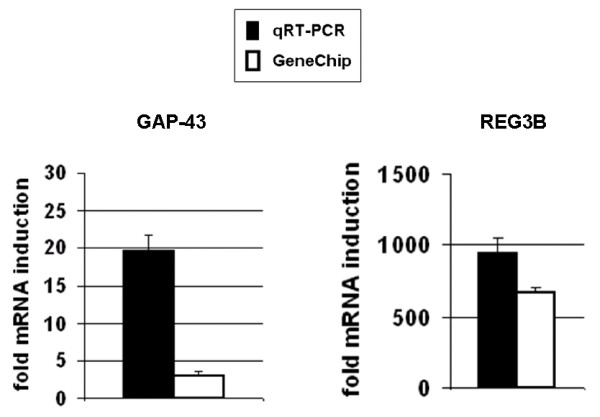
Changes in expression of GAP-43- and REG3B mRNA levels in IL-6-stimulated PC12 cells determined by qRT-PCR versus GeneChip. Affymetrix Genechip- and qRT-PCR analyses were performed as described in the Methods section.